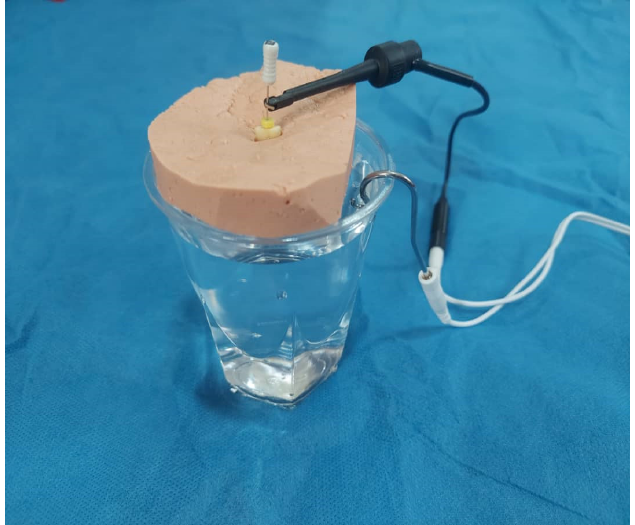
Figure 2. Experimental setup to measure the WL by the three apex locators.